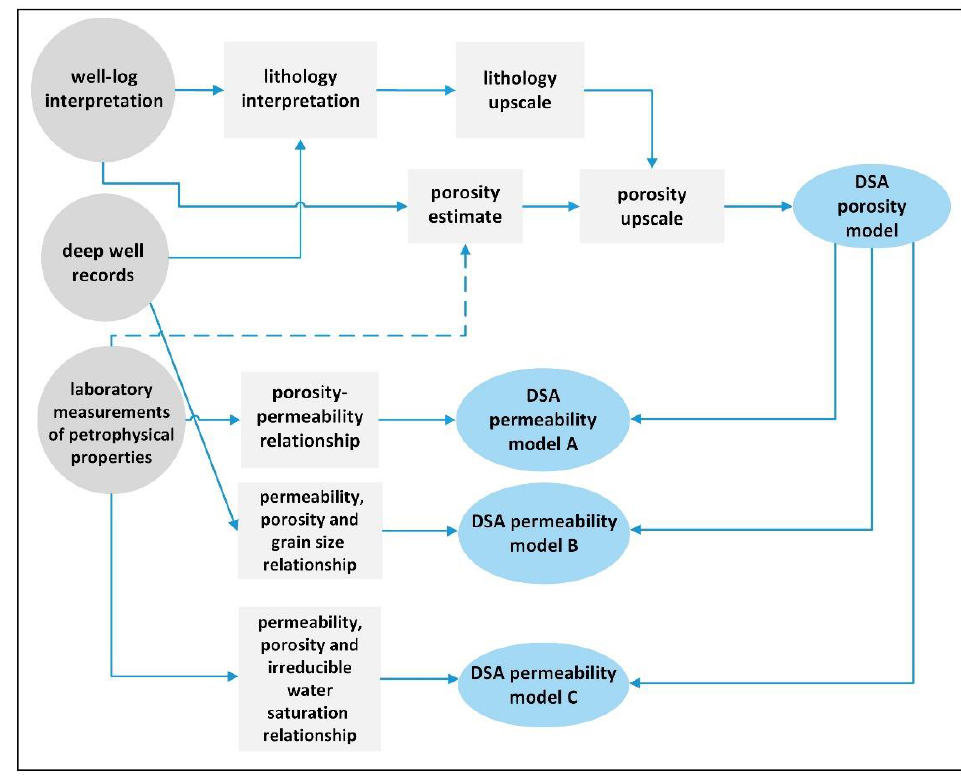
Figure 3. Process sequence of petrophysical model development.